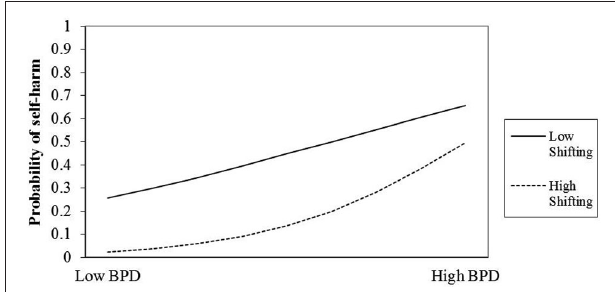
FIGURE 2 | Interaction of BPD and Shifting ability on likelihood of prior self-harm.